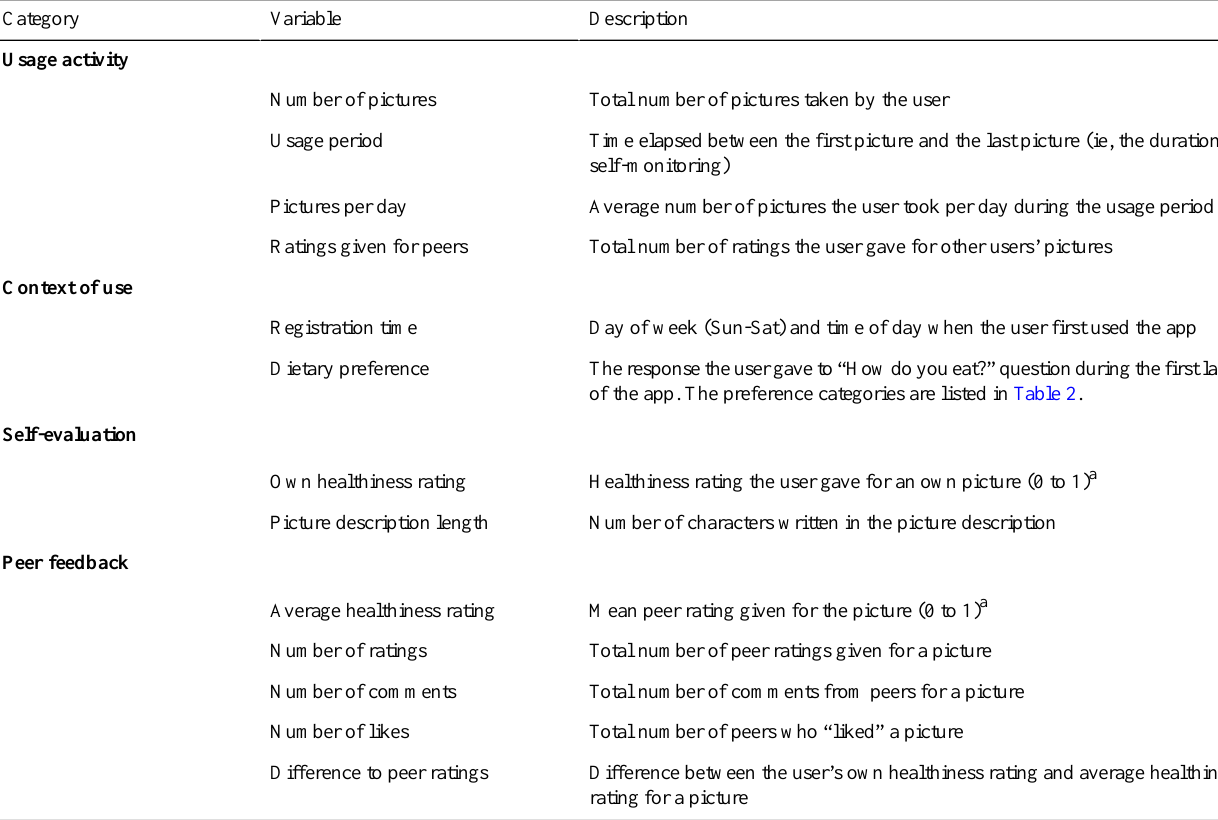
Table 1. Variables related to the usage of the mobile app “The